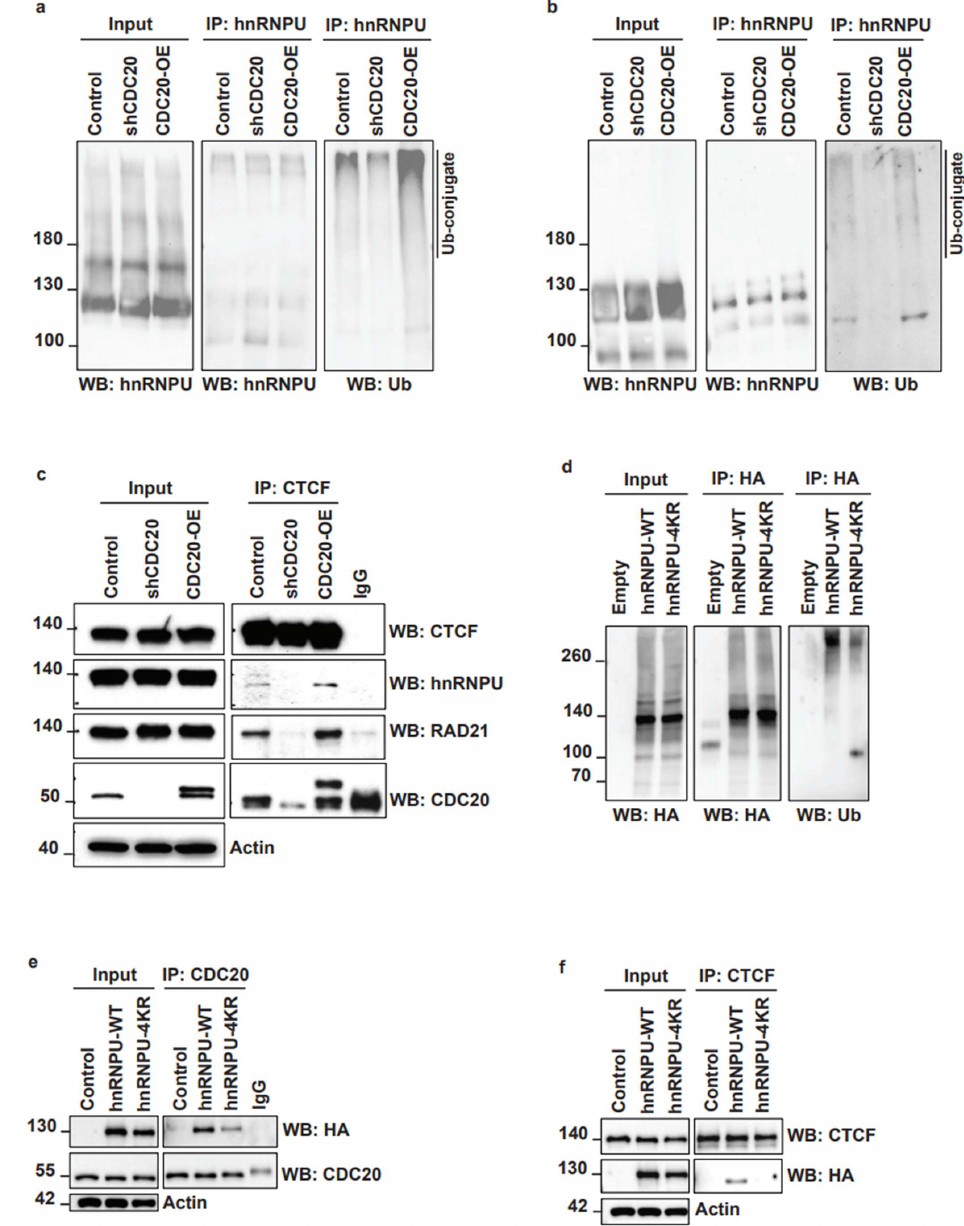
Figure 5. CDC20 regulates hnRNPU ubiquitination and its interaction with CTCF. ( a , b ) Ubiquitination of hnRNPU by CDC20. MDA-MB-468 control, expressing CDC20 knockdown or overexpressing CDC20 cells were crosslinked by using DSS ( a ) or not ( b ) before immunoprecipitation. The cell lysate was then immunoprecipitated with an anti-hnRNPU antibody. The level of ubiquitin was measured by immunoblot. ( c ) The cell lysate from MDA-MB-468 control, expressing CDC20 knockdown or overexpressing CDC20 cells was immunoprecipitated with an anti-CTCF antibody. The level of CTCF, hnRNPU, RAD21, and CDC20 was measured by immunoblot. ( d ) The cell lysate from MDA-MB-468 control, expressing hnRNPU-WT or hnRNPU-4KR was immunoprecipitated with an anti-V5 antibody. The level of ubiquitin was then measured by immunoblot. ( e ) The cell lysate from MDA-MB-468 control, expressing hnRNPU-WT or hnRNPU-4KR was immunoprecipitated with an anti-CDC20 antibody. The levels of HA-hnRNPU-WT or HA-hnRNPU-4KR were then measured by immunoblot. ( f ) The cell lysate from MDA-MB-468 control, expressing hnRNPU-WT or hnRNPU-4KR was immunoprecipitated with an anti-CTCF antibody. The levels of HA-hnRNPU-WT or HA-hnRNPU-4KR were then measured by